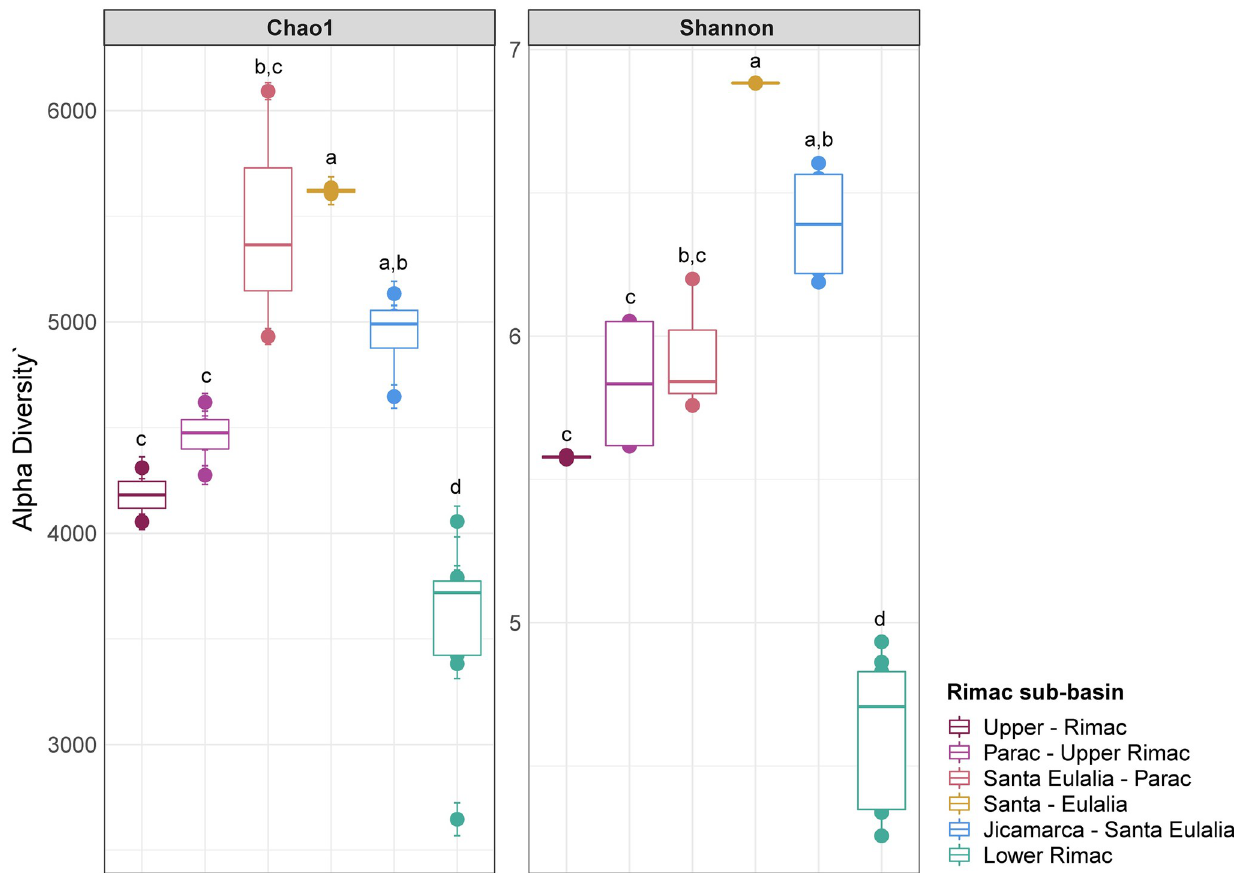
Fig 2. Alpha diversity indexes, Chao1 (richness) and Shannon (diversity) in the samples. The Lower Rimac localities consistently showed lower richness and diversity values in comparison to other sub-basins. Letters above boxplots represent significant differences (p < 0.05) between average values of each